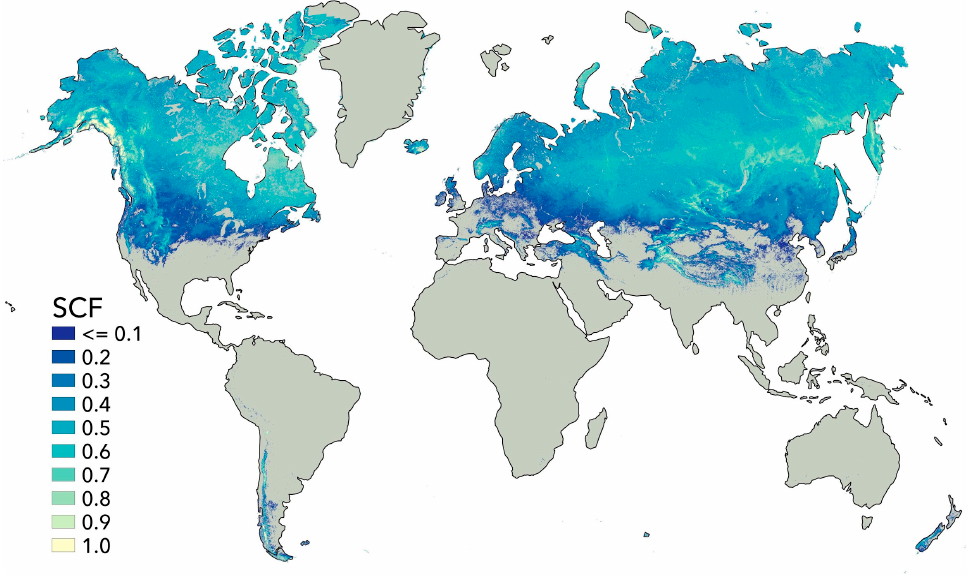
Figure 2. Global snow cover frequency (SCF) aggregated to 2 km resolution for the 2016 water year generated using Google Earth Engine and the MOD10A1 snow cover area product.